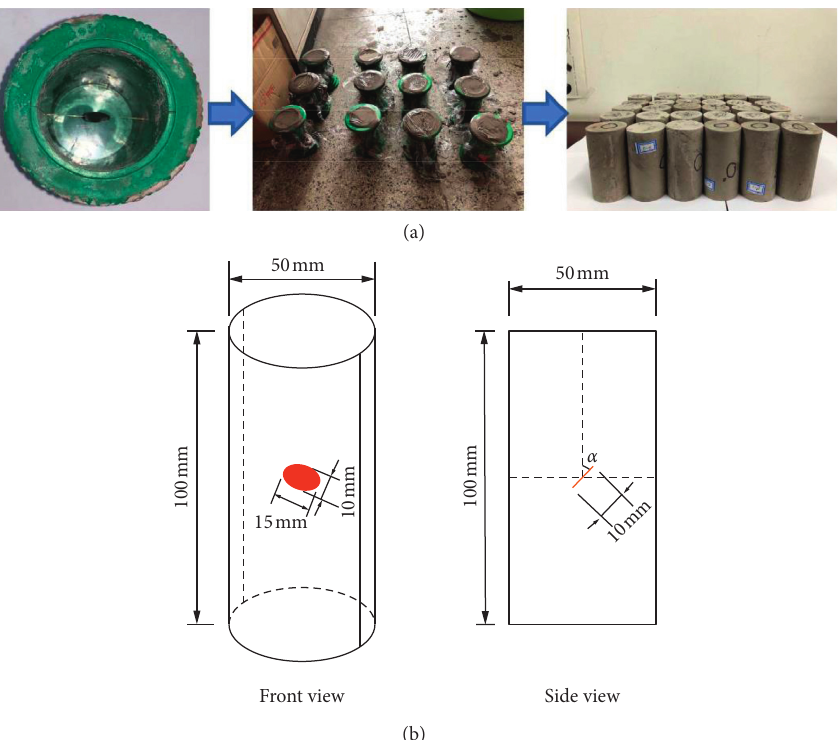
Figure 1: The samples preparation. (a) Making process of the samples. (b) Schematic diagram of the samples.